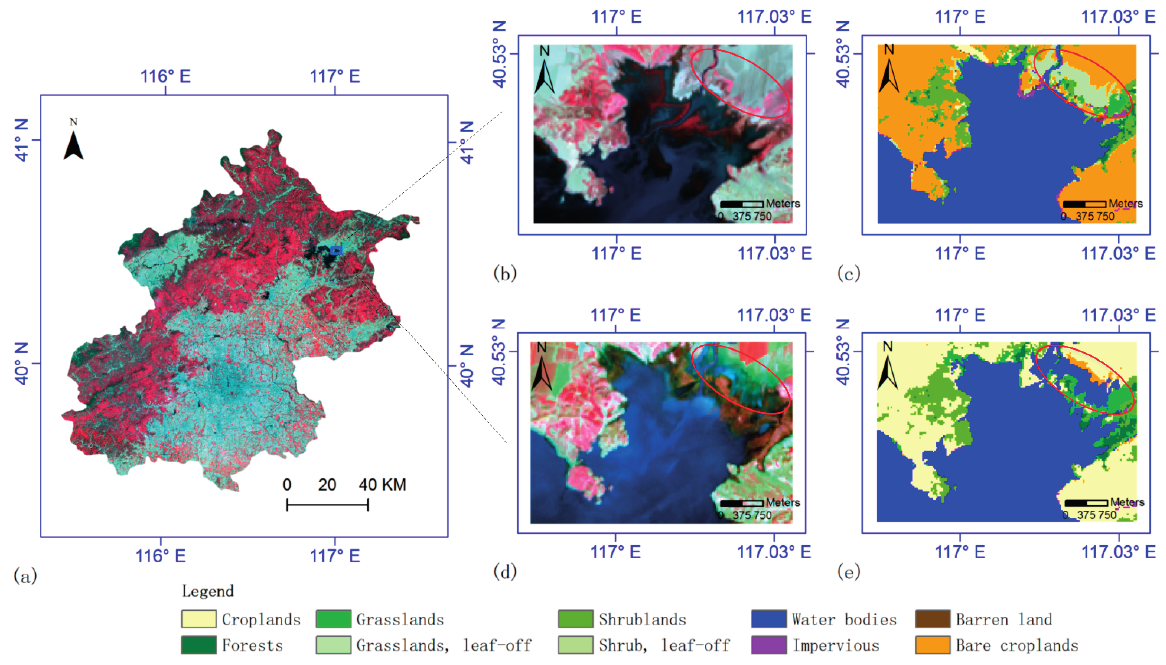
Figure 6. Regional results classified with all the 144 features. The blue region in study area ( a ) indicates the area shown in ( b – e ). The false color images (R: band 5, G: band 4, B: band 3) in ( b ) and ( d ) are from data acquired on day of year (DOY) 132 and DOY 276. And the mapping results are in ( c ) and ( e ). Red ellipses indicate the most dynamic